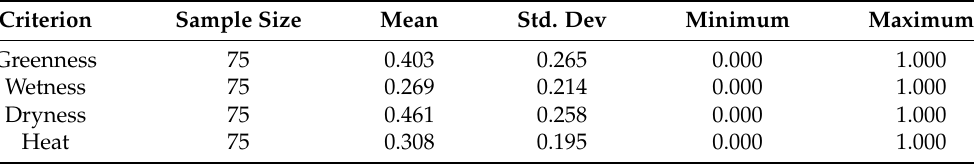
Table 5. Descriptive statistics for ecological criteria after